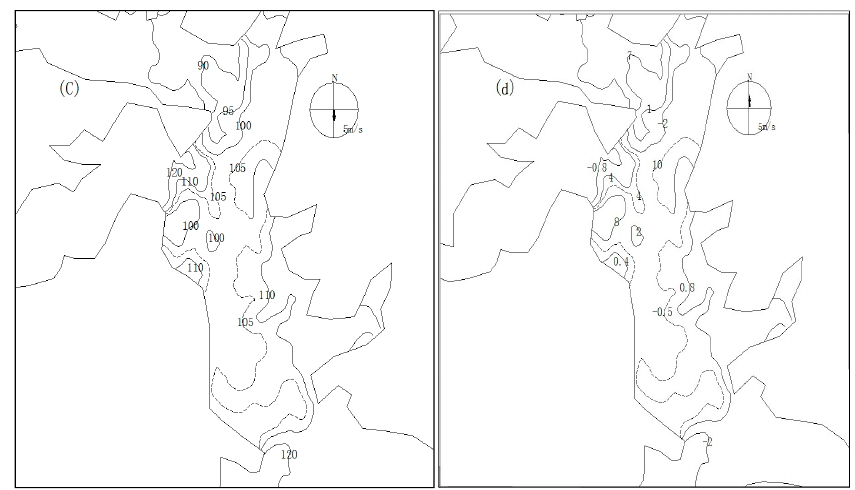
Figure 10. Temporal and spatial distribution of water age in two days with opposed wind directions: ( a ) north wind in tail areas; ( b ) south wind in tail areas; ( c ) north wind in head area; ( d ) south wind in head area.